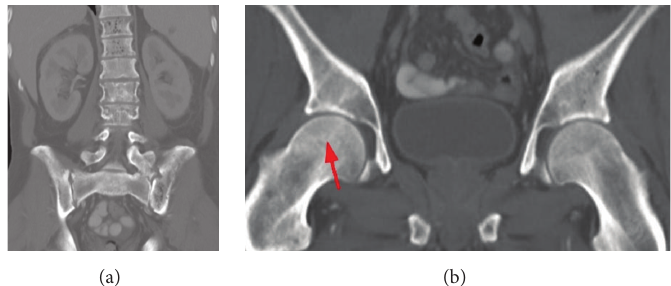
Figure 5: Coronal intravenous contrast enhanced CT images obtained 3 days after Figure 4. These images show (a) progression of osteonecrosis now involving the lumbar spine. (b) There is also subtle evidence of osteonecrosis of the right hip (arrow).